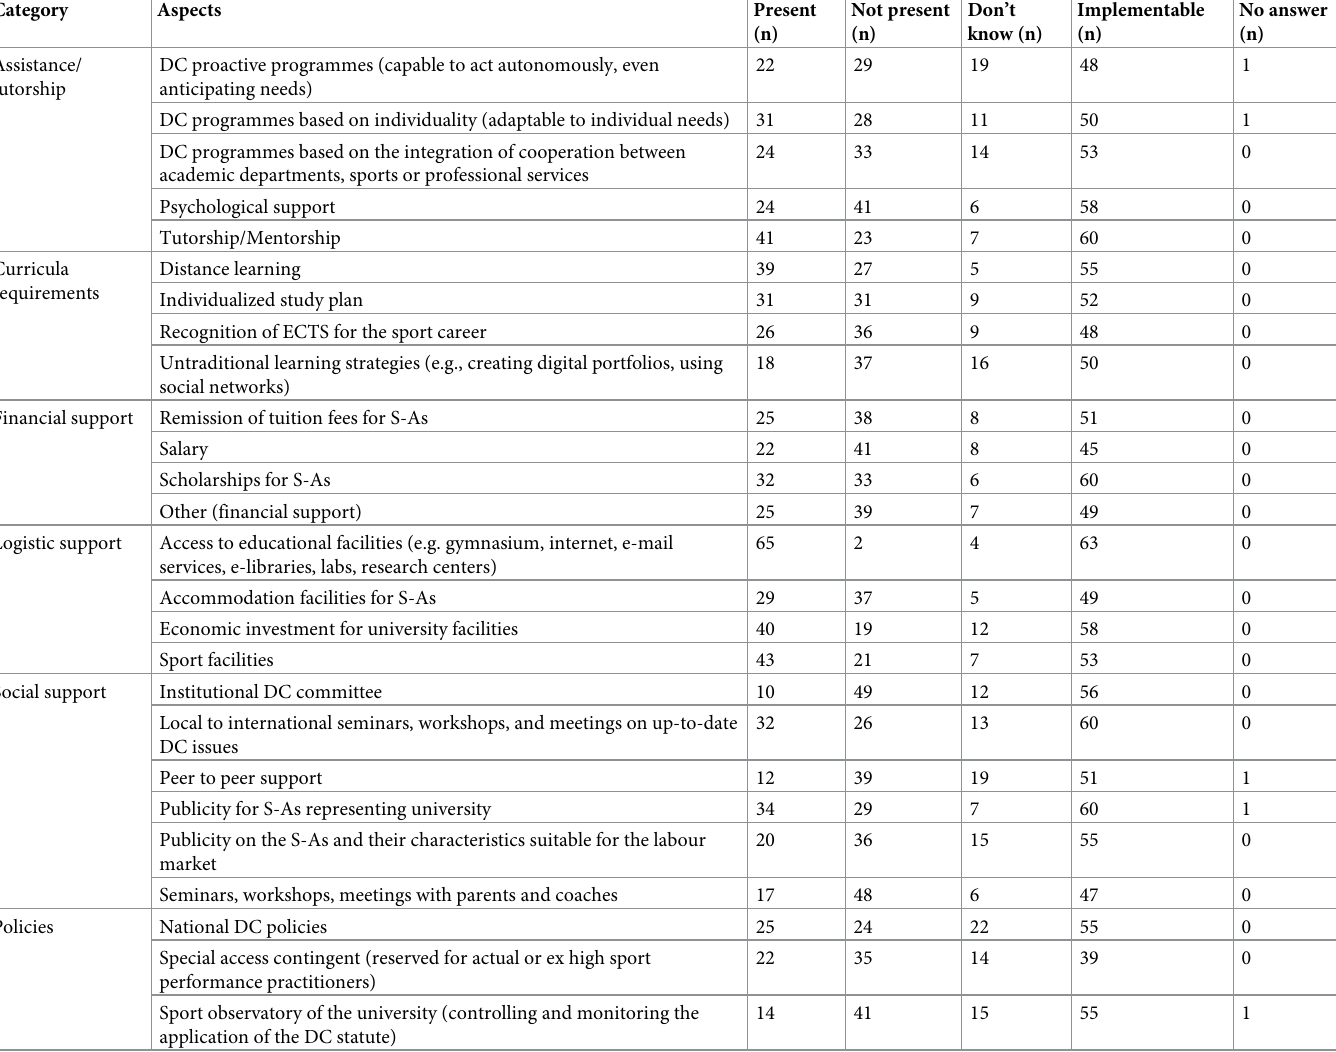
Table 2. Frequency of occurrence of dual career services for student-athletes at the higher education